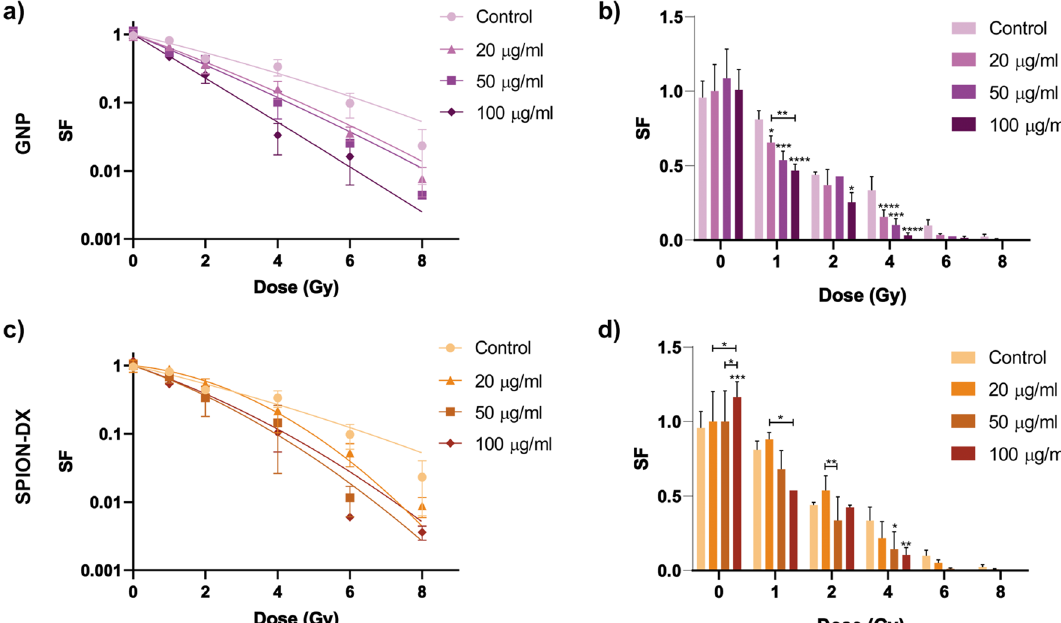
Figure 2. Cell survival curves for U87 GBM cells treated with GNPs( a,b ), and SPION-DX( c,d ) at concentrations of 20, 50 and 100 µ g/mL. Data for untreated cells (control) are also shown.. Samples were irradiated by photons from a 6 MV Linac accelerator in triplicate. The same data was plotted as bar graphs for a better visualization of single dose effects. p -values are presented as: * p < 0.05 ; ** p < 0.01 ; *** p < 0.001 ; **** p < 0.0001